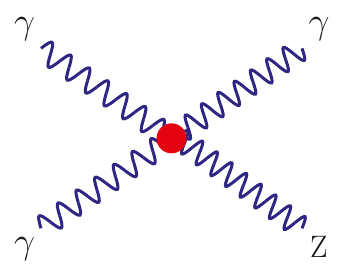
Figure 1 . The process γ + γ → γ + Z